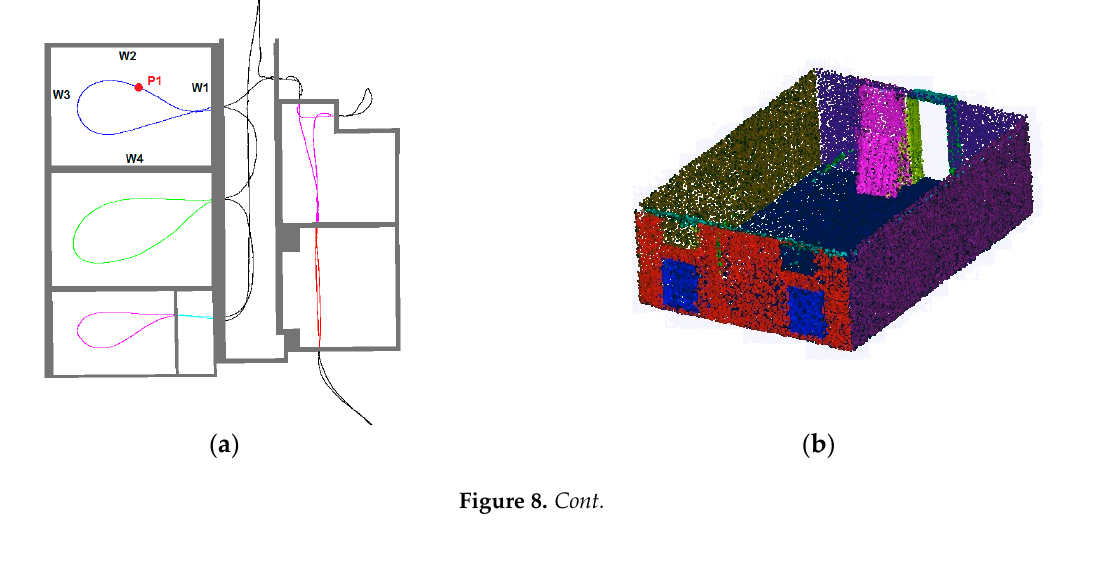
( f ) Figure 8. Reconstruction of openings: ( a ) position P 1 of the MLS sensor used to compute the occupancy map for Room 1; ( b ) segmented point cloud for Room 1 (ceiling is removed to look into the room); and ( c – f ) occupancy maps generated for the four walls in Room 1 (in gray—occupied cells, in red—occluded cells, and in green—openings). 3.6. Element Classification and Model Generation A procedure similar to the one described in [33] is used to classify openings into windows and doors as well as to recognize their shape. In particular, a hierarchical classification tree is used (Figure 9). Openings are classified as doors when they intersect with the ground floor. Once the raw shape of the openings is determined priors on indoor architecture are added to generate the room